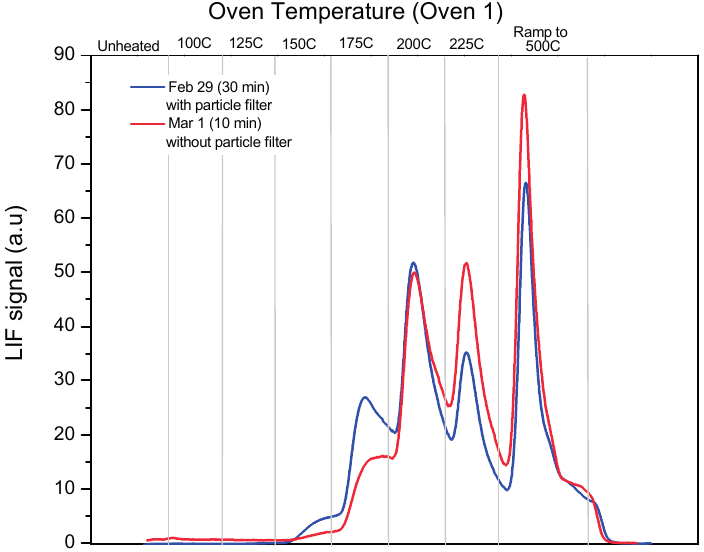
, NO and CO as measured by 2 y 2